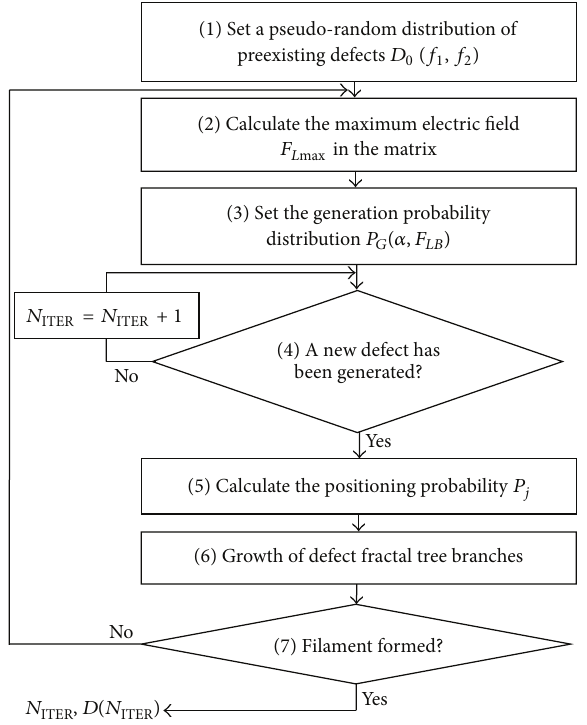
Figure 2: Flow diagram of the simulation procedure described in the